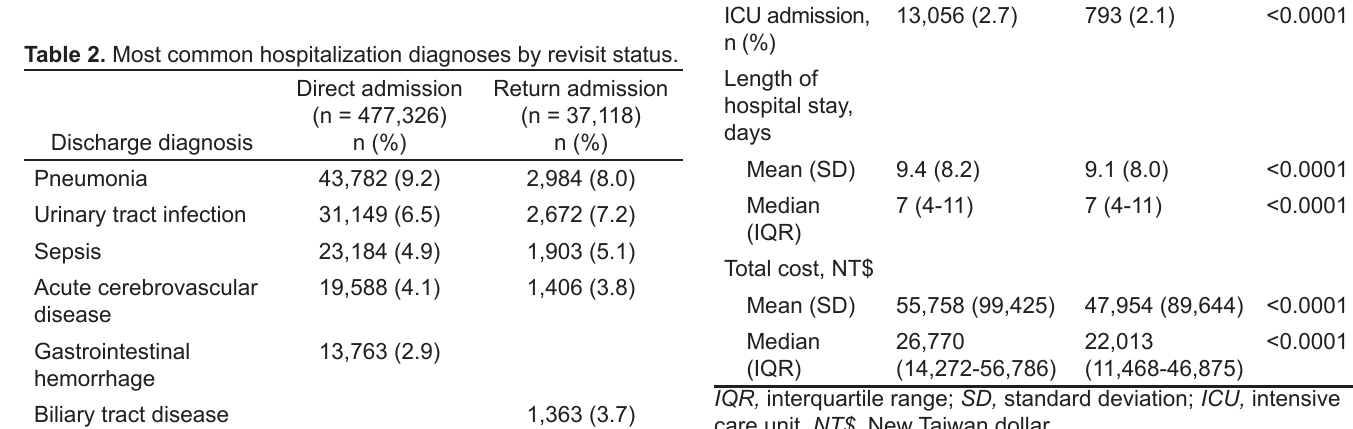
IQR, interquartile range; SD, standard deviation; ICU, intensive care unit, NT$, New Taiwan